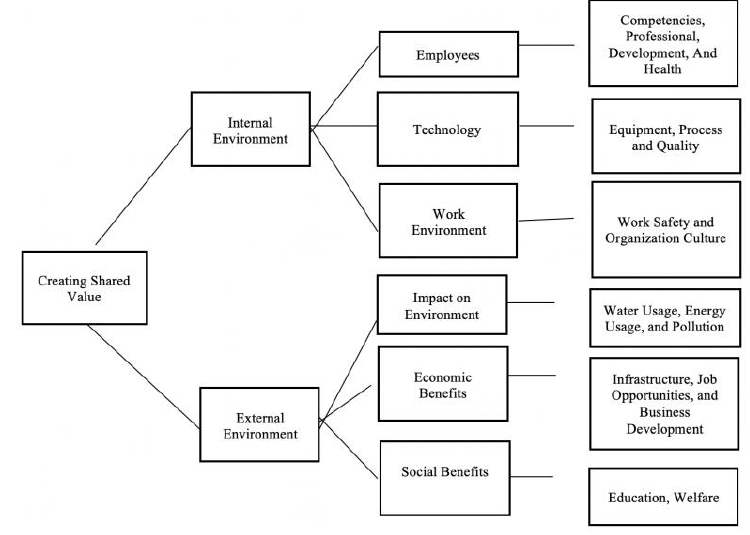
Figure 2: Company Scope in Creating Shared Value; Source: Inga Lapina , et al